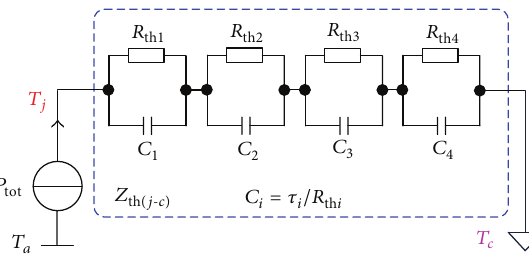
: heat-sink to ambient impedance. th (ℎ - 𝑎)